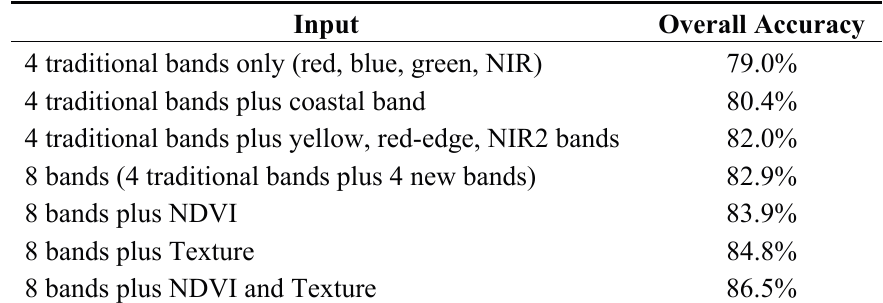
Table 4. Variation of classification accuracy with different combinations of WV2 spectral bands, NDVI, and texture for 22 classes of wetland and aquatic